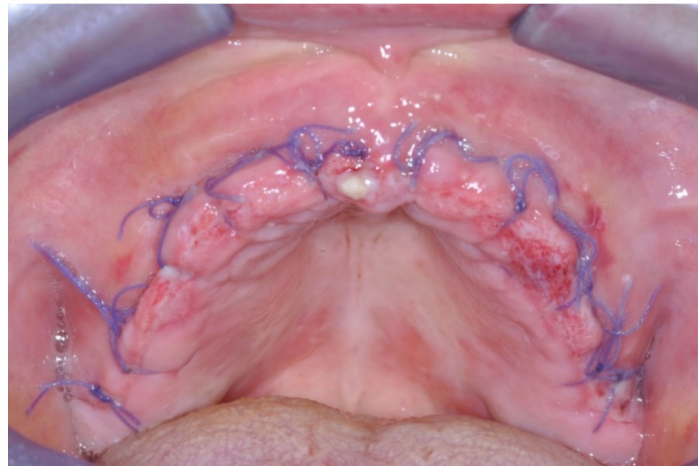
Figure 16. One week after, the left side showed delayed healing. Healing of the sites occurred undisturbed and no biological or prosthetic complications occurred. All 33 implants placed in the regenerated sites with the “sling technique” showed 100% survival after a follow-up of more than 24 months. After the regenerative procedure, all implants were surrounded by at least 2 mm of bone